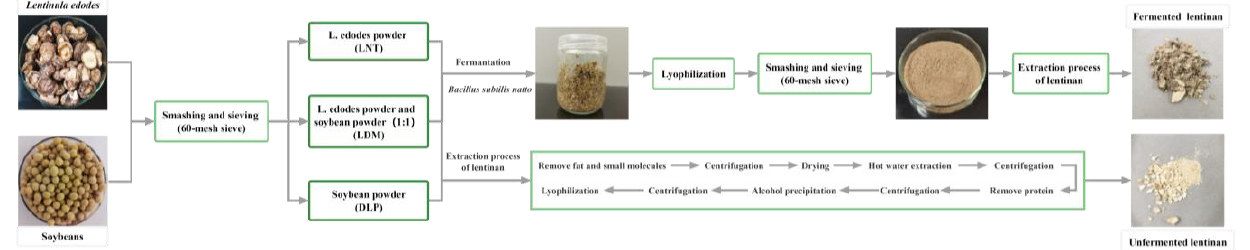
Figure 1. The preparation process of lentinan from fermented and unfermented Lentinula edodes and soybeans.